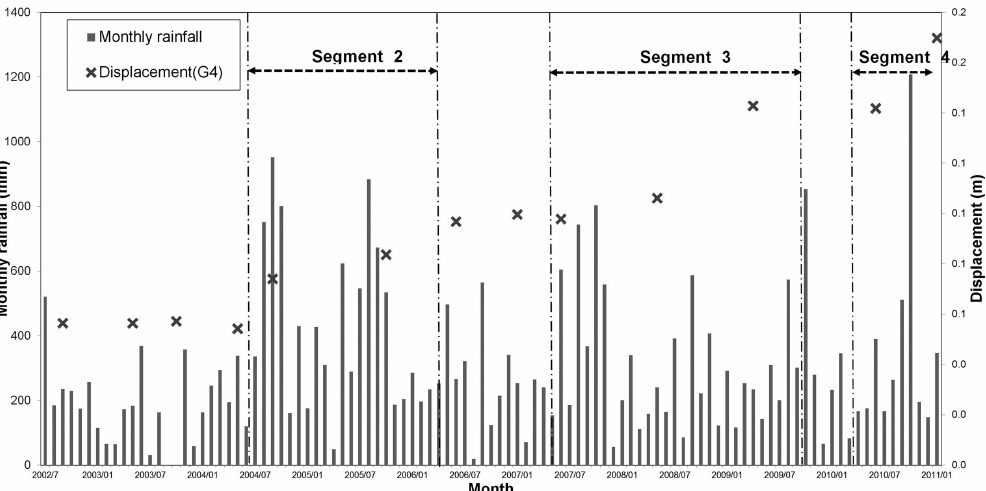
Figure 2. Correlation of monthly rainfall and slope displacement of point G4, which is an observation point at the Hui-Tsui building (B1). It is enlarged and shown in Fig. 6. The slope displacement recorded at point G4 is measured to be greater during the periods of higher